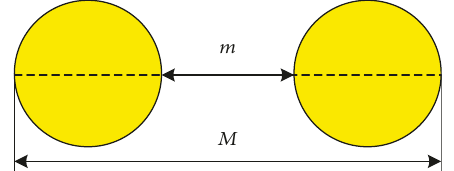
Figure 1: Distribution area of node positions of